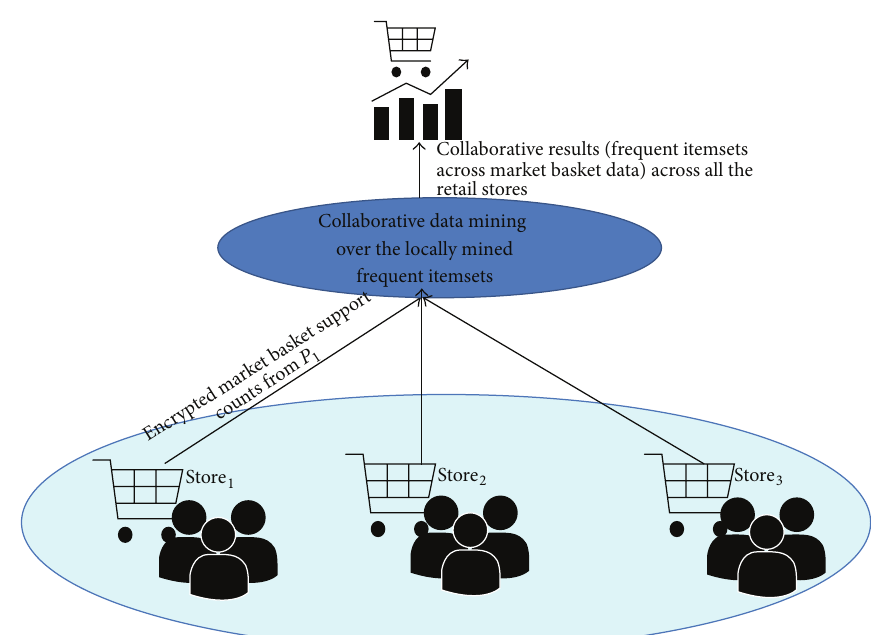
Figure 2: Collaborative market basket analysis. An application scenario for